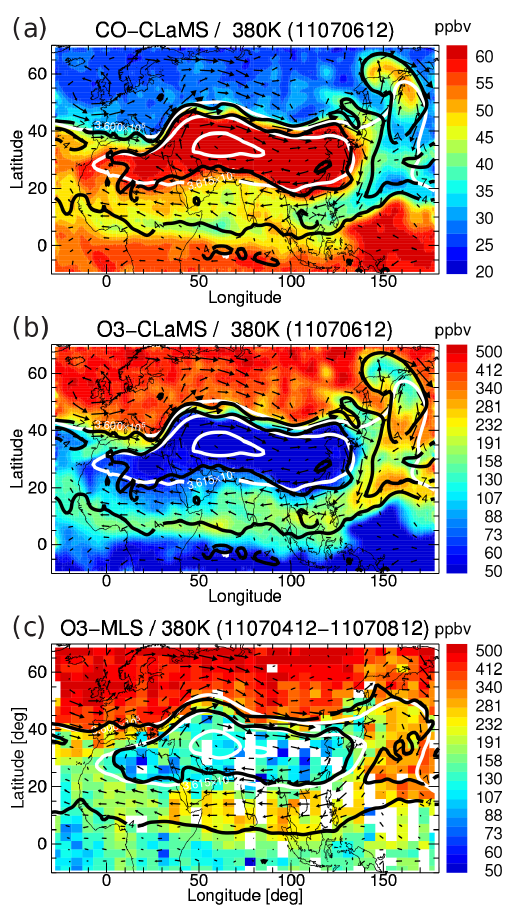
Figure 2. Maps of (a) CLaMS CO and (b) CLaMS ozone on the 380K isentrope on 6 July 2011 within the Asian monsoon region. Selected potential vorticity contours are shown in black (4, 7PVU) and Montgomery stream function contours in white (3 . 6 × 10 5 , 3 . 615 × 10 5 m 2 s − 2 ). Arrows show horizontal wind. (c) Same but for MLS ozone data sampled during the period 4–8 July 2011, with the MLS data binned into 3 ◦ × 6 ◦ latitude/longitude bins (bins with- out measurements are left white). Meteorological data are taken from ERA-Interim. (Note the logarithmic color scale for ozone.)